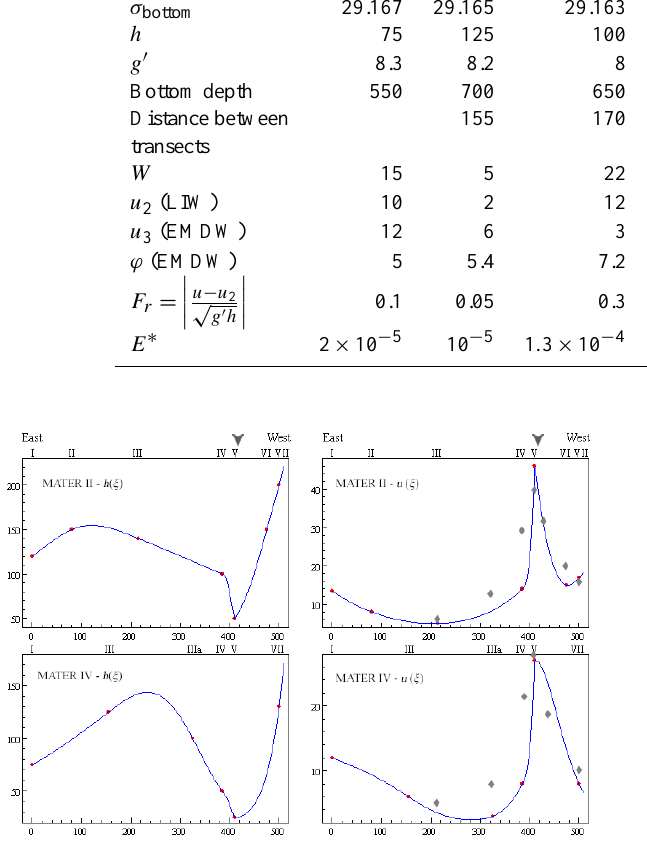
Figure 5. Modified spline interpolation of h i (m) and u i in (cms − 1 ) along ξ (km); Roman numerals indicate hydrograph tran- sects shown in Figs. 3 and 4, for MATER II cruise and MATER IV, respectively. The black arrows at the top show the position of the sill. Diamonds represent the cross sectional maximum velocities as obtained by the Sannino et al. (2009) numerical model (see